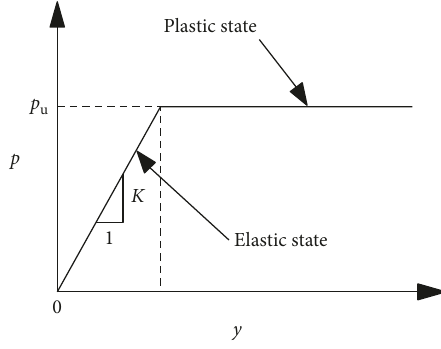
Figure 1: Ideal elastic-plastic p - y curve.